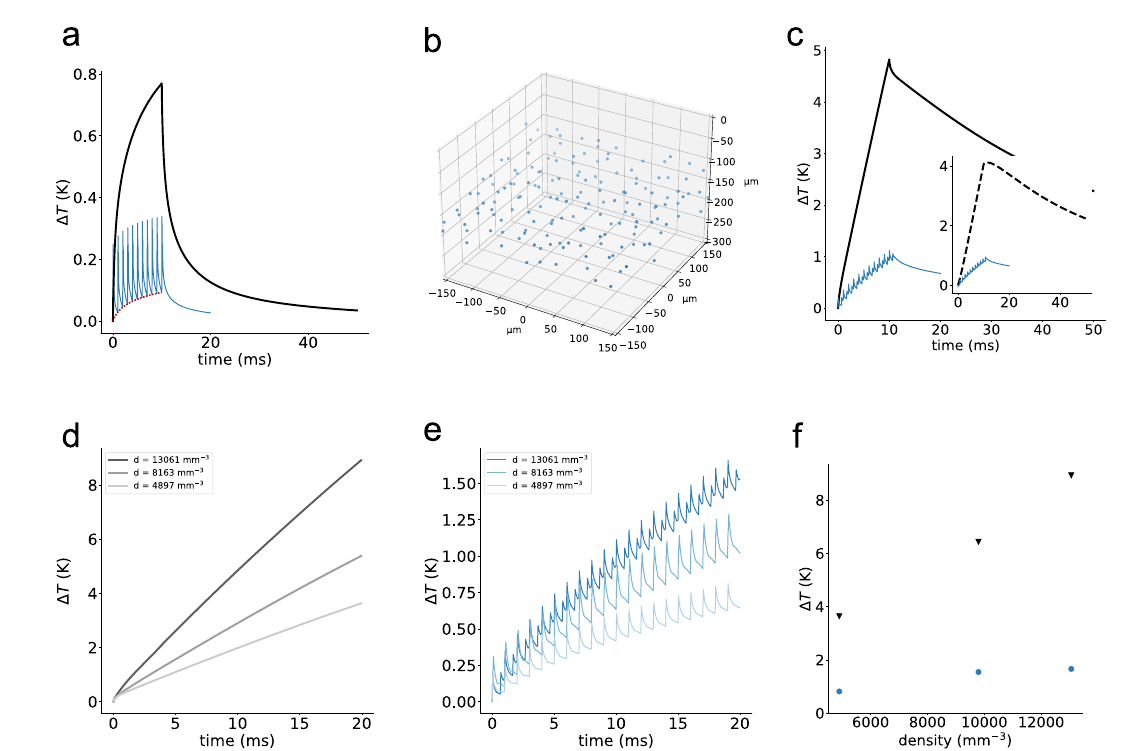
Fig. 5 | Simulatedtemperature riseunder cyclic and conventional holographic illumination. a Temperature rise induced on an illuminated spot under conven- tional (black) and cyclic -illumination (blue), using a power per cell, P std , of 10mW ffiffiffiffiffiffi (cid:4)p ffiffiffiffi p (cid:4) 10mW, in conventional and cyclic -illumination, respec- and P cyc = H P std = H tively; illumination t dw = 10ms; H =20; 50 µ s illumination pulses; 1ms per each cycle b Volumetric distribution of 160 spots ( H =20 holograms, m =8 spot per hologram) uniformly distributed in a 350×350×100 µ m 3 volume. c Temperature rise induced on a central spot when 160 spots are illuminated as depicted in ( b )